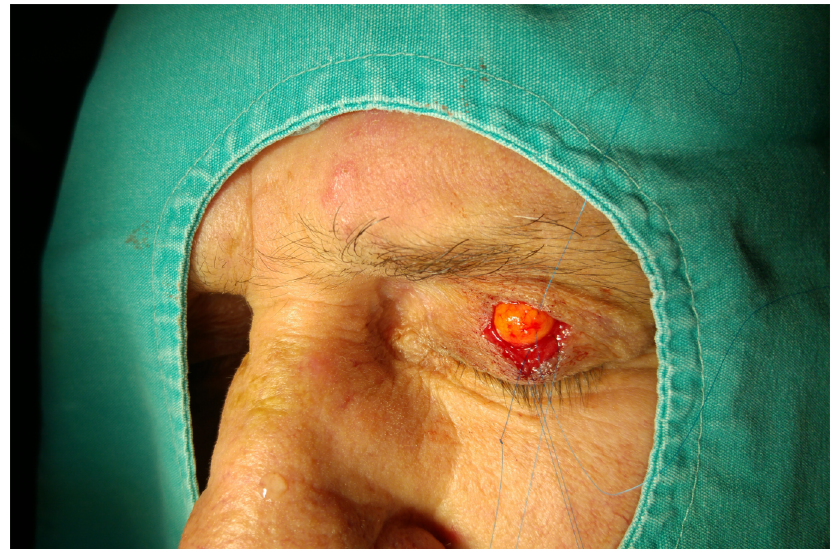
Figure 1: An intraoperative photograph of the lesion showing a mass on the upper eyelid crease, which was adherent to the